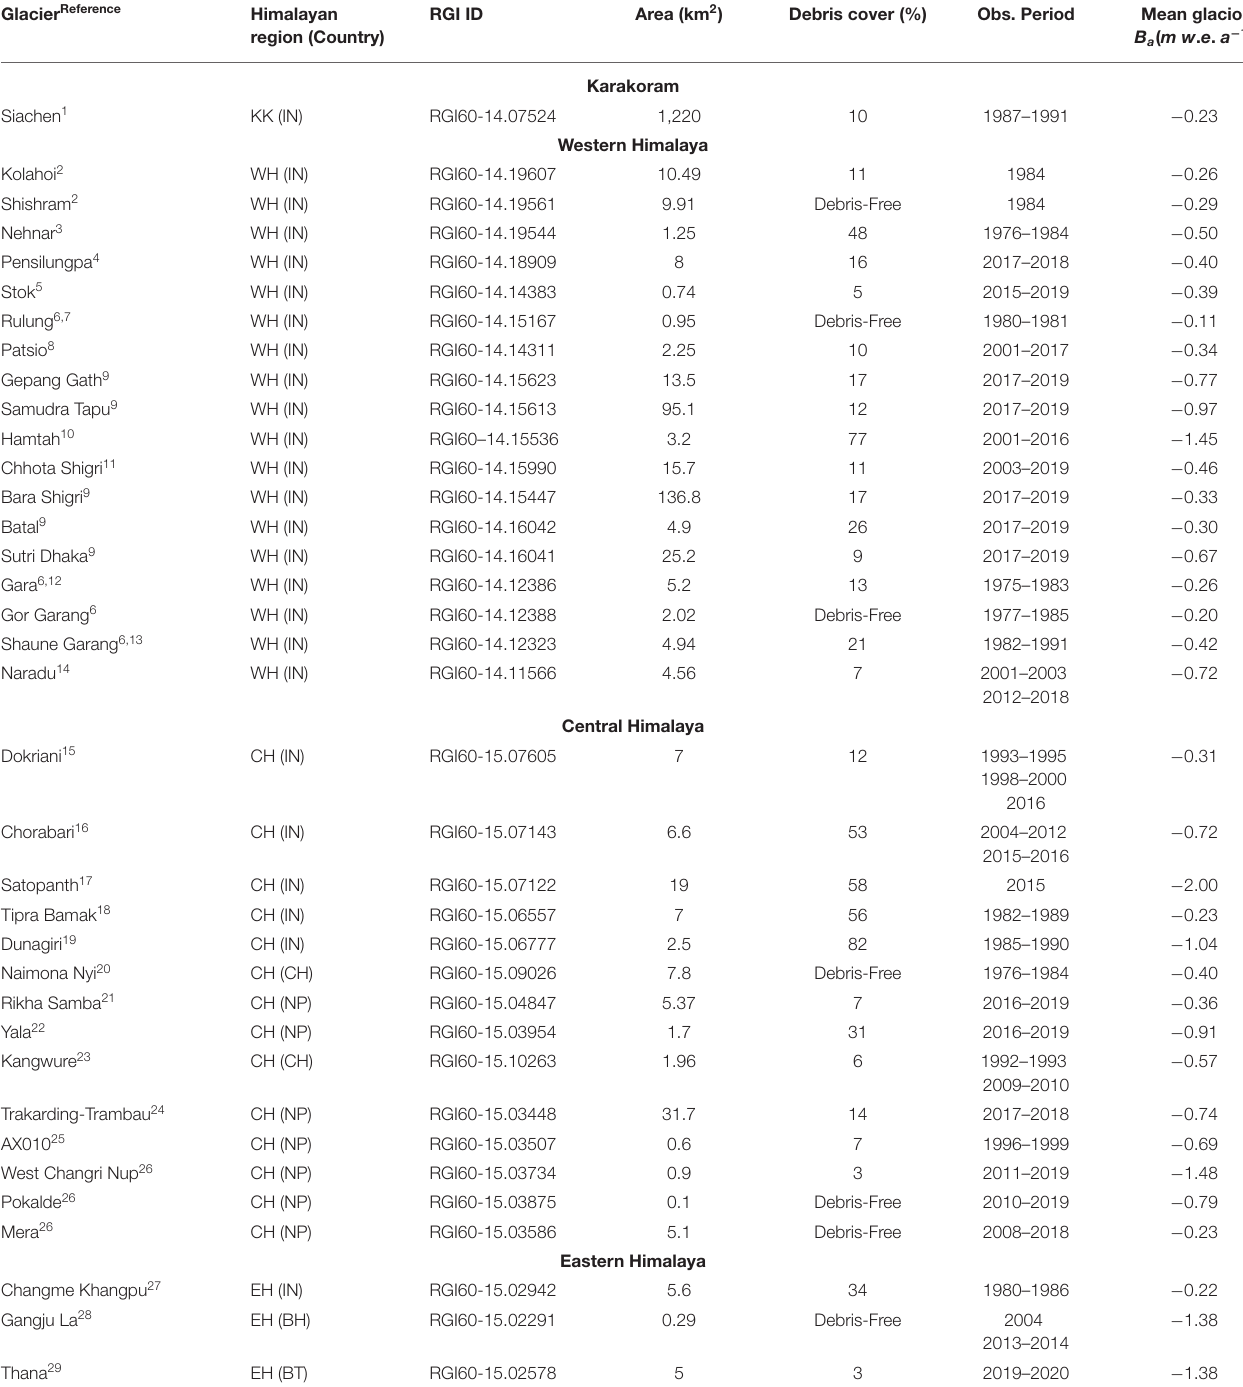
TABLE 1 | Glaciological ( in-situ ) mass balance of Himalayan glaciers (only Siachen Glacier mass balance is based on hydrological method). Glacier